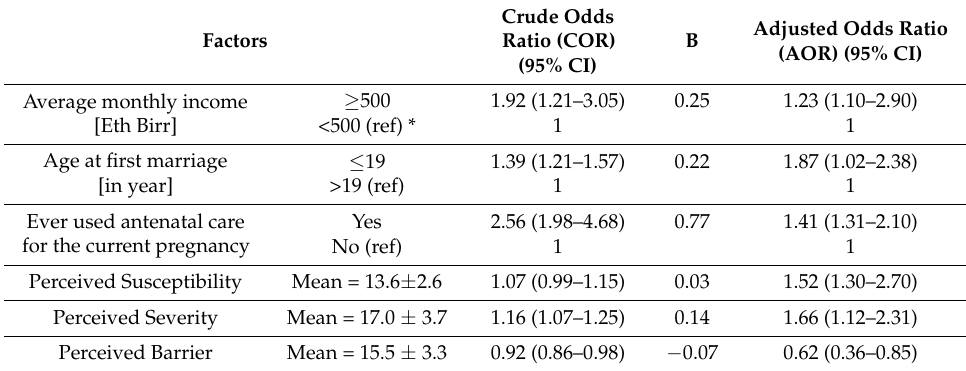
Table 3. Factors associated with pregnant women’s intention to use a health facility for delivery, Gabi-Rasu zone, Afar region, Ethiopia,